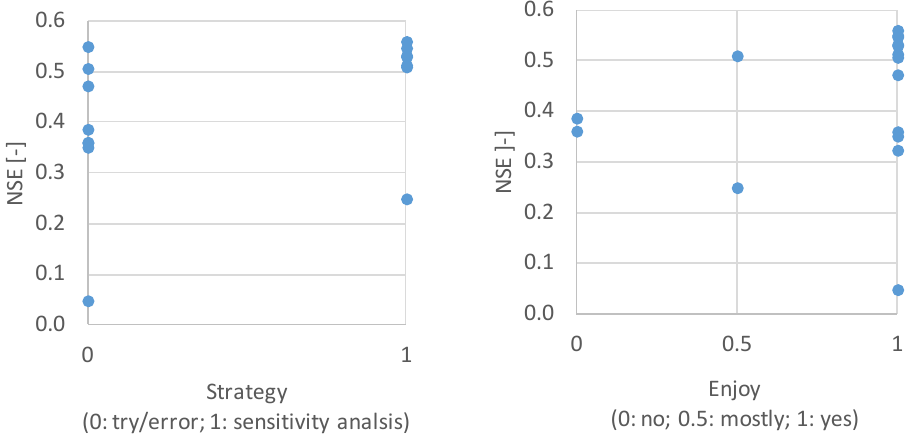
Figure 6. Dependence of model results (Nash-Sutcliffe model efficiency) on the calibration strategy ( Left ) and on whether the modellers’ enjoyed the modelling contest or not ( Right ). For graphical reasons, the results of one modeller are not shown who achieved an NSE value of − 45.9 (trial and error calibration, mostly enjoyed the contest).